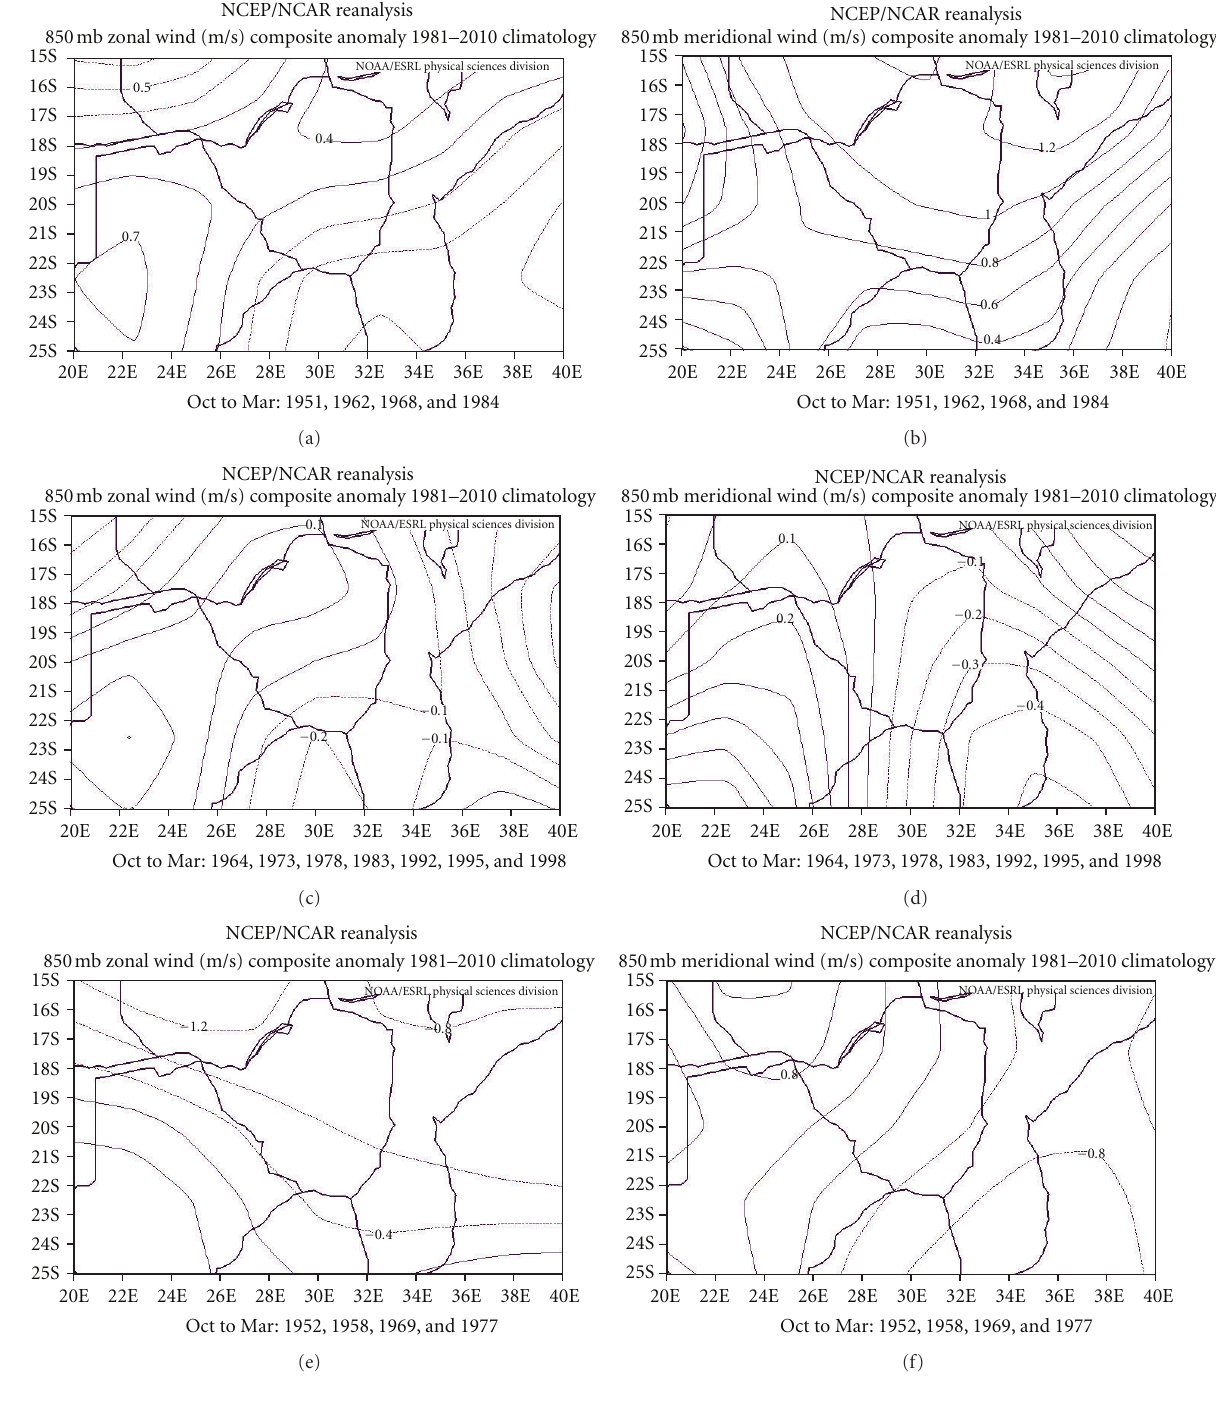
Figure 10: Zonal (left) and meridional (right) wind pattern (m/s) for the 850 mb pressure level for (a) and (b) pure IODZM composite, (c) and (d) cooccurrence composite, and (e) and (f) pure El Ni˜no composite over the east-central southern African region.